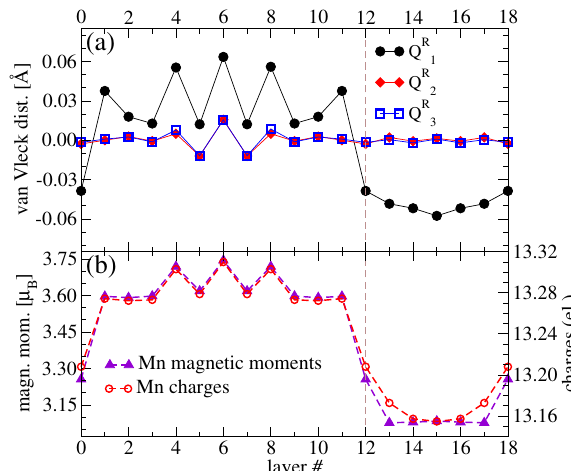
Fig. 2 Correlation between distortions and charge. a Layer- resolved van Vleck distortions. b Mn-projected Bader charges and magnetic moments. The dashed vertical line indicates the interfacial layer. The charge transfer across the interface is visible in having Bader charges larger (lower) than for the nominal oxidation state, i.e., 13 (14) in the SrMnO3 (LaMnO3) region. A more direct visualisation of the structure with respect to the layers numbering is provided in Fig.